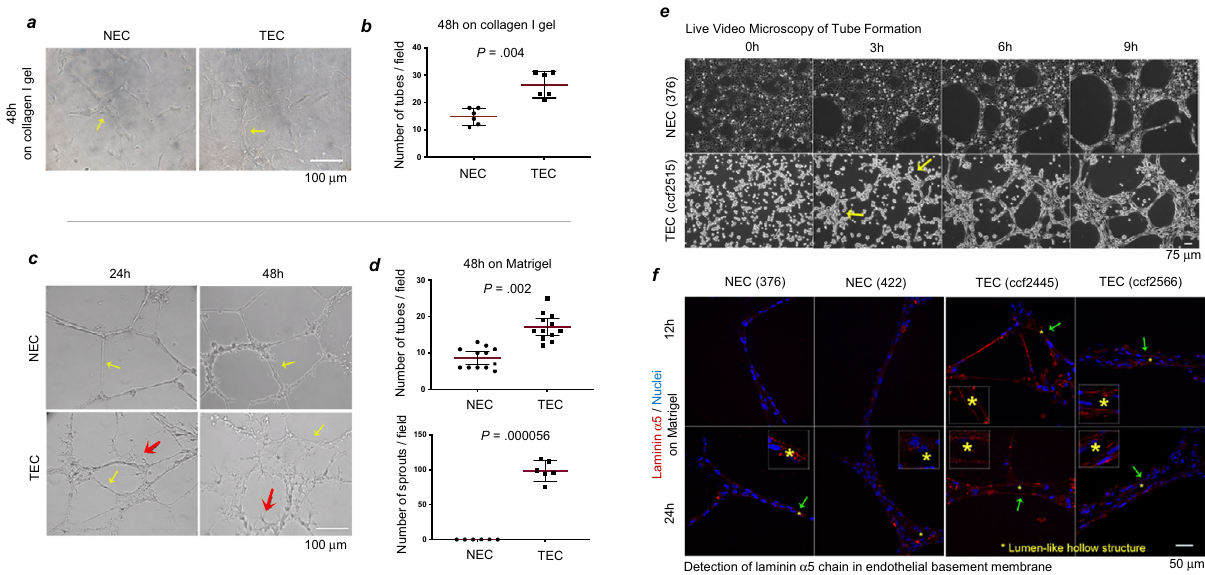
Fig. 1 Elevated numbers of tubes and sprouts formed by TECs as compared to NECs and more rapid tube formation in TECs. a , b NECs (422) and TECs (isolate ccf2687) were cultured for 48 h in collagen gels as described in Methods. Representative images are shown in a , b is the corresponding statistical analysis by two-sided Wilcoxon rank-sum tests. Yellow arrows denote tubes. n = 6 different fi elds in each group. c , d NECs (623) and TECs (isolate ccf2445) were cultured on Matrigel for 24 h or 48 h. Representative images are shown in c , d is the corresponding statistical analysis by two-sided Wilcoxon rank-sum tests. Yellow arrows denote tubes and red arrows denote sprouts. For tube numbers, n = 12 different fi elds in each group; and for sprout numbers, n = 6 different fi elds in each group. Red and black bars in b , d indicate means with 95% con fi dence intervals. e Live video microscopy of NECs (376) and TECs (isolate ccf2515) over the fi rst 9 h of culture on Matrigel. Representative images are shown. f Immuno fl uorescent staining of laminin α 5 chain (sc-16592; Alexa-Fluor-594; red) in the basement membrane of tubes formed by NECs (376 and 422) and TECs (isolates ccf2445 and ccf2566) on Matrigel for 12 and 24 h. Cell nuclei stained with DAPI (blue). Independent experiments were performed at least two times with similar results. Source data are provided as a source data fi